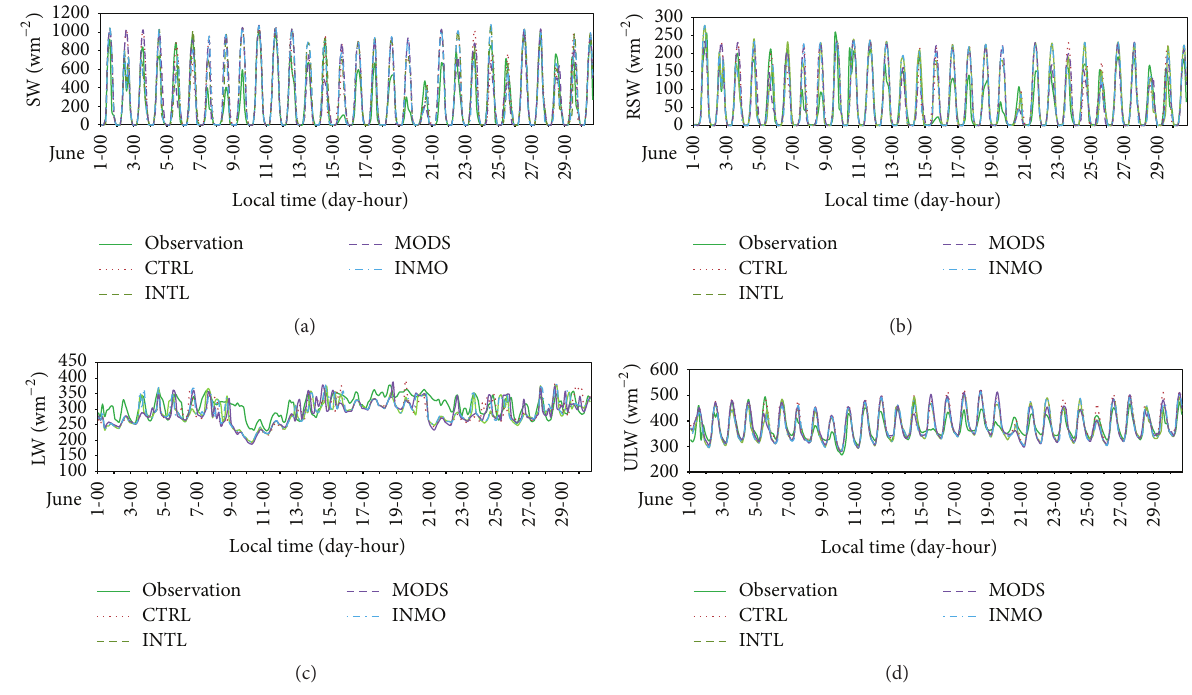
Figure 3: Comparison of modeled and observed surface radiation at Arou station: (a) solar short-wave radiation (SW), (b) reflected short- wave radiation (RSW), (c) atmospheric long-wave radiation (LW), and (d) upward long-wave radiation (ULW).